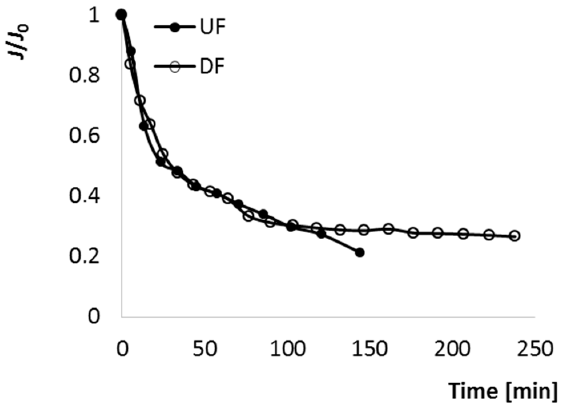
Figure 2. The changes of J / J 0 during ultrafiltration (UF) and diafiltration (DF) of cloudy apple- cranberry